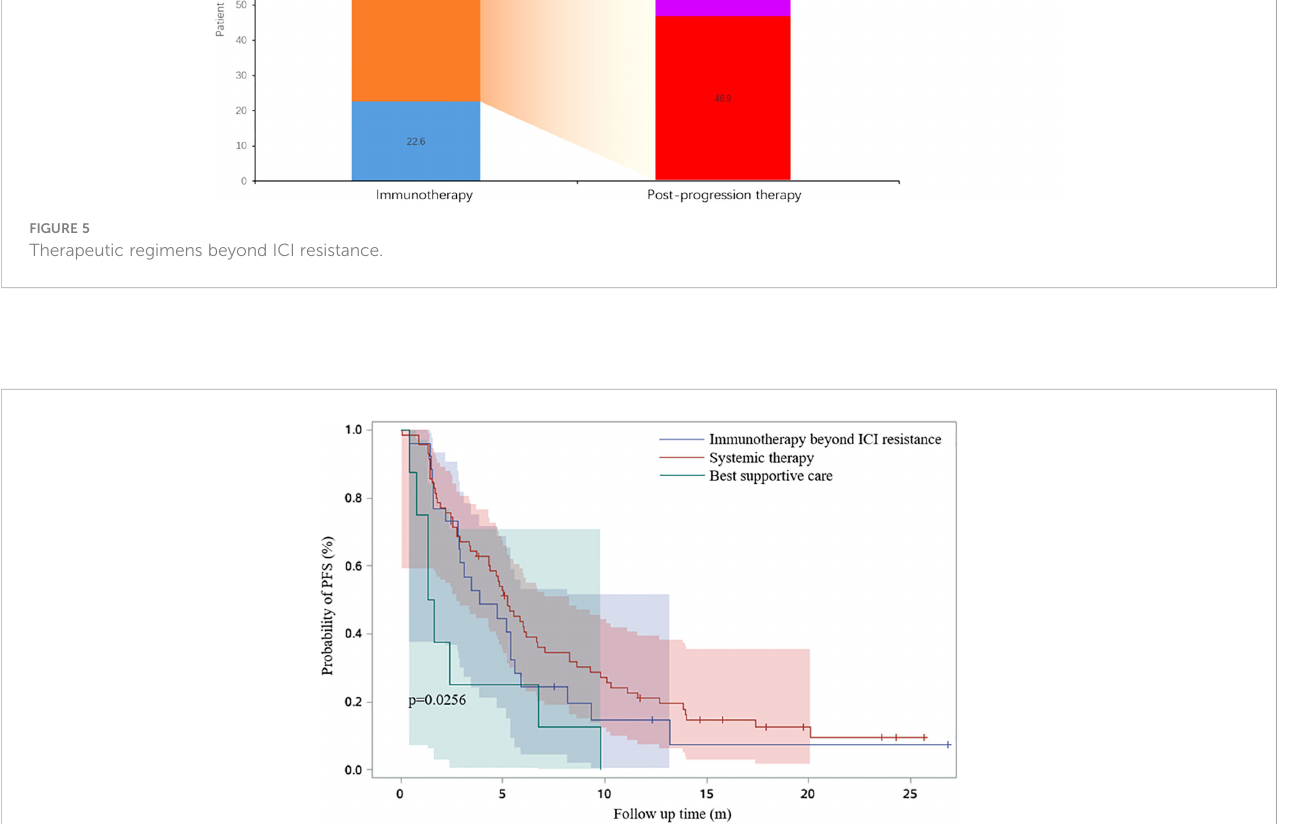
FIGURE 6 Survival curves based on Kaplan-Meier for different therapeutic regimens beyond ICI